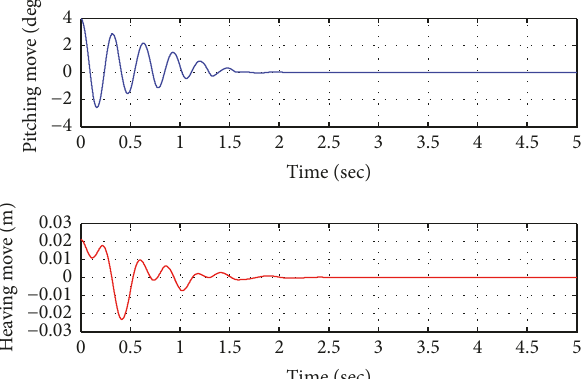
Figure 10: Closed-loop responses (controlled flutter) in pitch and plunge oscillation amplitude in two- dimensional wing, versus time (in degree and meter,